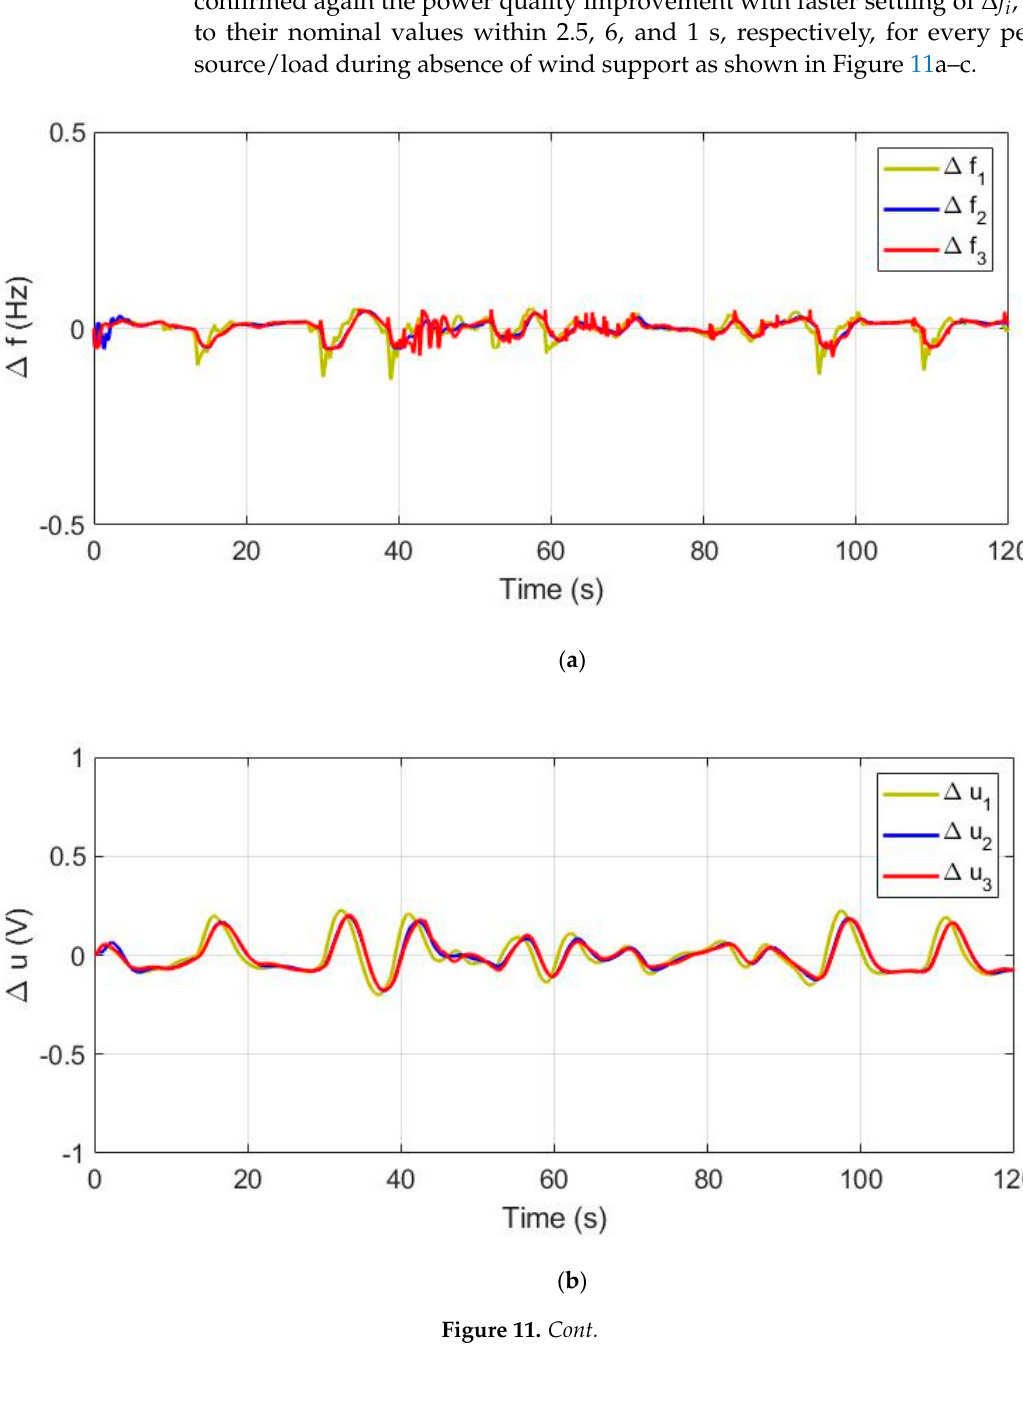
Figure 10. Case 2: ( a ) frequencies ( Δ f i ), ( b ) voltages ( Δ u i ), and ( c ) Δ P tij responses.